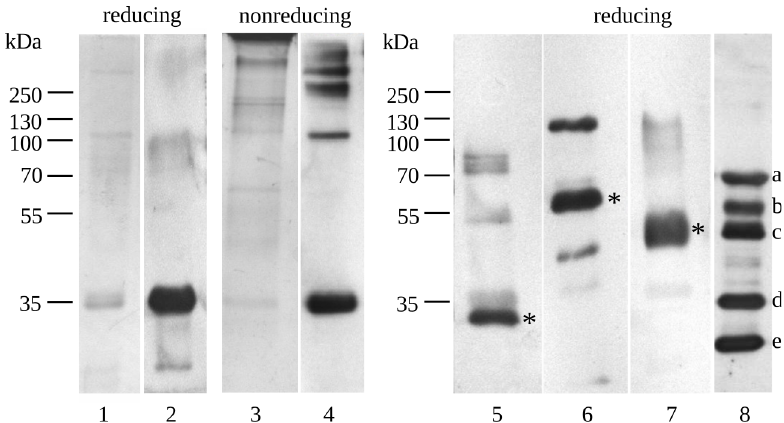
Fig 3. Detection of ficolin-3, MASPs and Ig in plasma-derived ficolin-3 complexes. Analysis of ficolin-3 preparation (1 μ g of final product) fractionated on a 10% polyacrylamide gel under reducing (lanes 1, 2, 5 – 8) or non-reducing (lanes 3 – 4) conditions. Coomassie Blue stain (lanes 1, 3) and Western blotting using anti- ficolin-3 (lanes 2, 4), anti-MASP-1 (lane 5), anti-MASP-2 (lane 6), and anti-MASP-3 (lane 7) antibodies. The last lane (8) is the strip 4 re-probed with anti-human IgG, IgA and IgM. MASP bands are marked with asterisks ( * ). A, b, c – heavy chains of IgM (a), IgA (b), IgG (c); d- ficolin-3 monomer; e- light chains of Ig. The positions of the molecular mass markers are indicated in